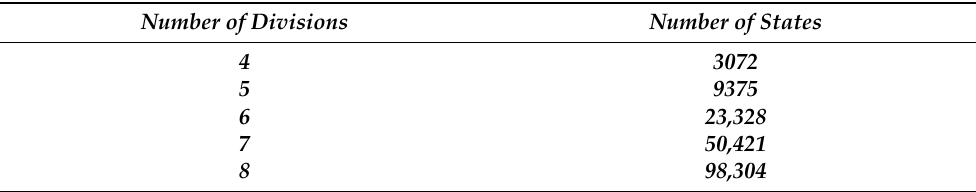
Table 1. Number of distance divisions and number of